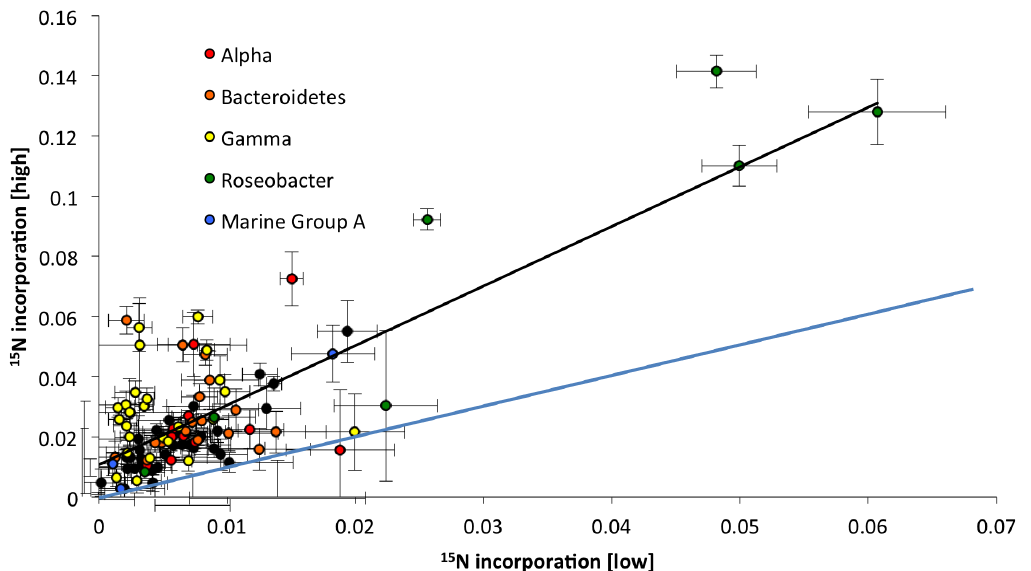
Figure 1. Pairwise comparisons of isotopic incorporation of 15 N labeled AAs by 107 16S rRNA phylotypes from SF Bay at two concentrations (high, 5 micromolar and low, 50 nanomolar). Each data point represents the HCE (hybridization corrected enrichment) for a probe set (the slope of delta permil divided by fluorescence). Error bars indicate two standard errors of the slope calculation. The black line represents the linear regression and the blue the 1 to l line.